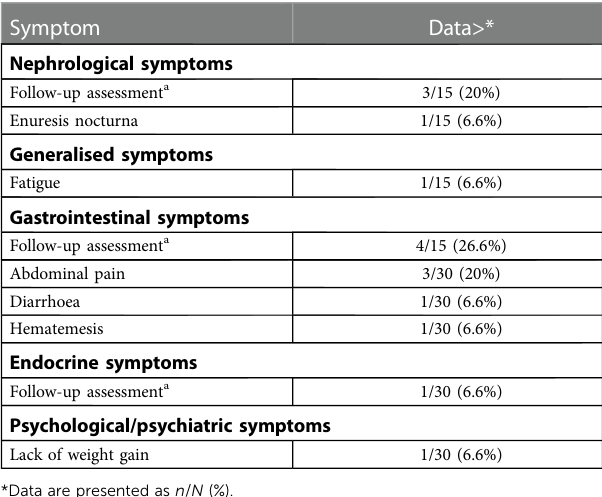
TABLE 3 Description of symptoms in the control